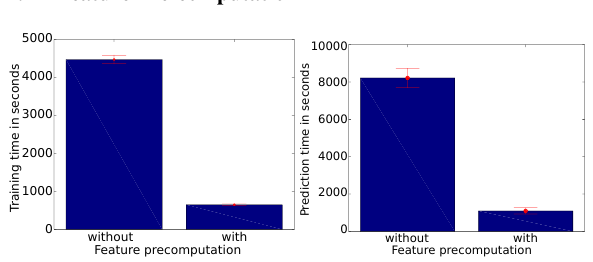
Figure 3. Change in training and prediction time by using precomputed features.